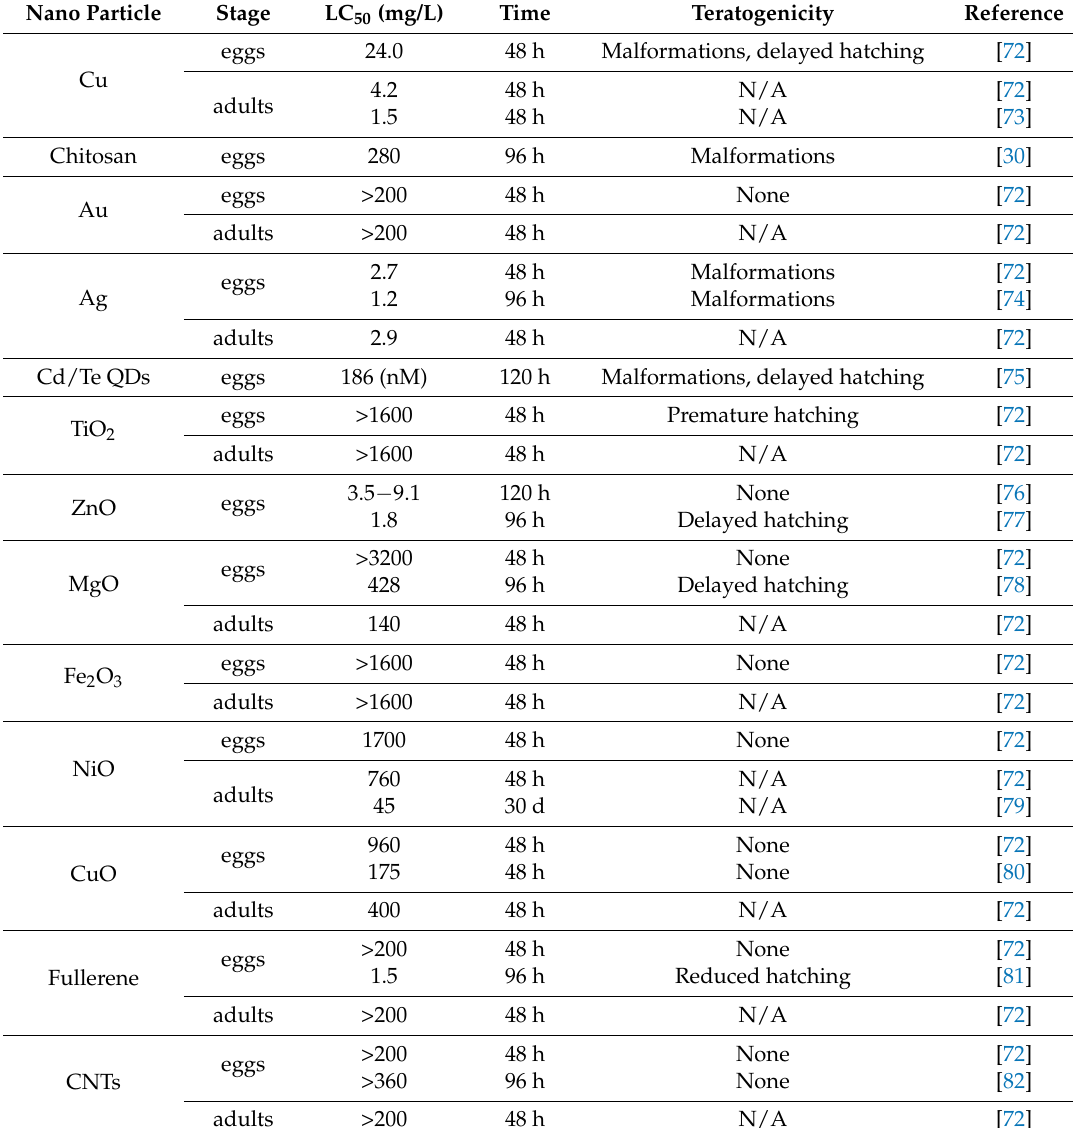
Table 1. LC 50 toxicity testing in zebrafish embryos and adults of nanoparticles detailed in this review and selected